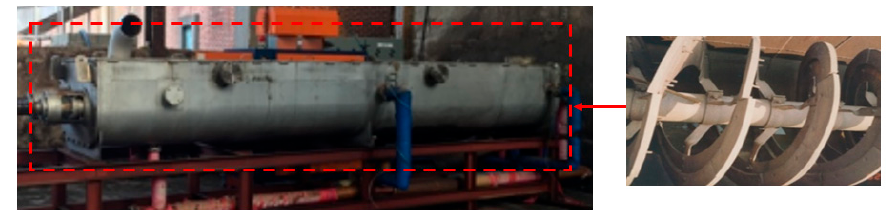
Figure 2. The livestock manure dryer with screw-type manufactured in the field.